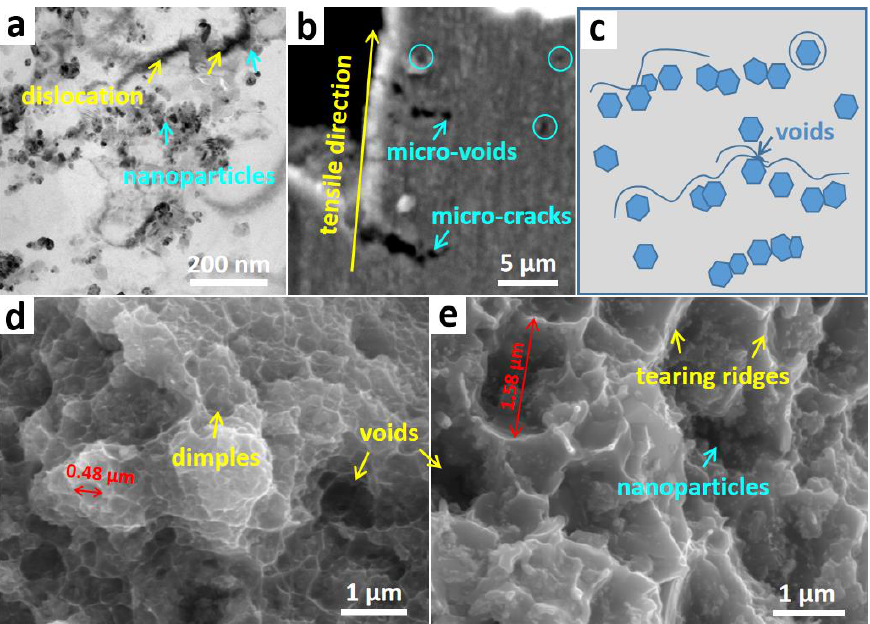
Figure 6. The characterization on the post-tensile sample of the composite: ( a ) is the TEM image; ( b ) is the FESEM result; ( c ) is the schematic showing the dislocation behavior in the tensile process; ( d , e ) The fracture surfaces of the composite after testing at 25 °C ( d ) and 350 °C ( e ).